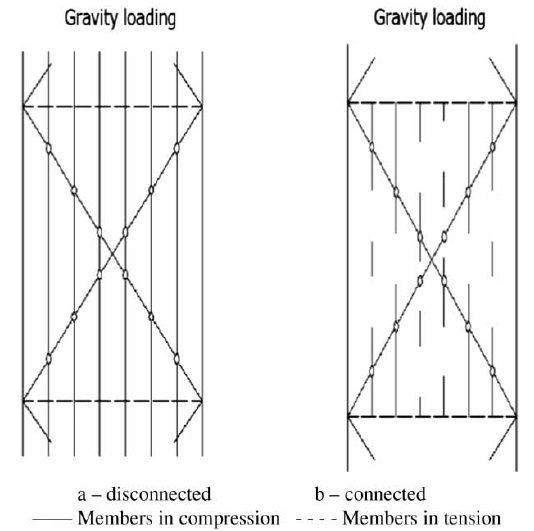
Fig. 8. Gravity load path in LSB systems (Stafford Smith, Coull 1991)